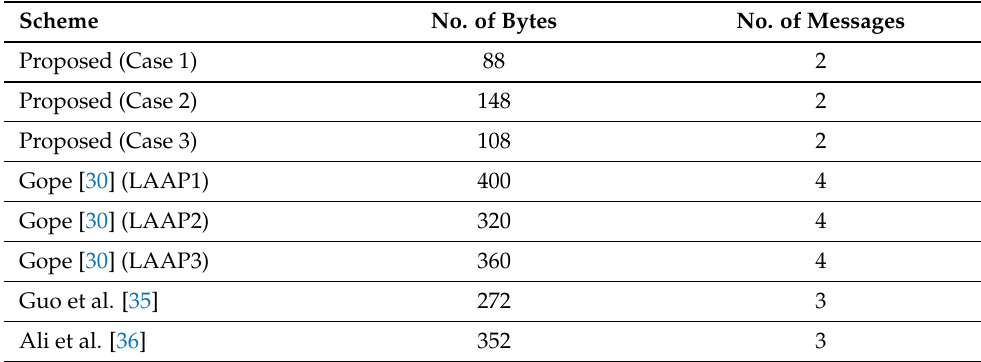
Table 5. Communication costs comparison.